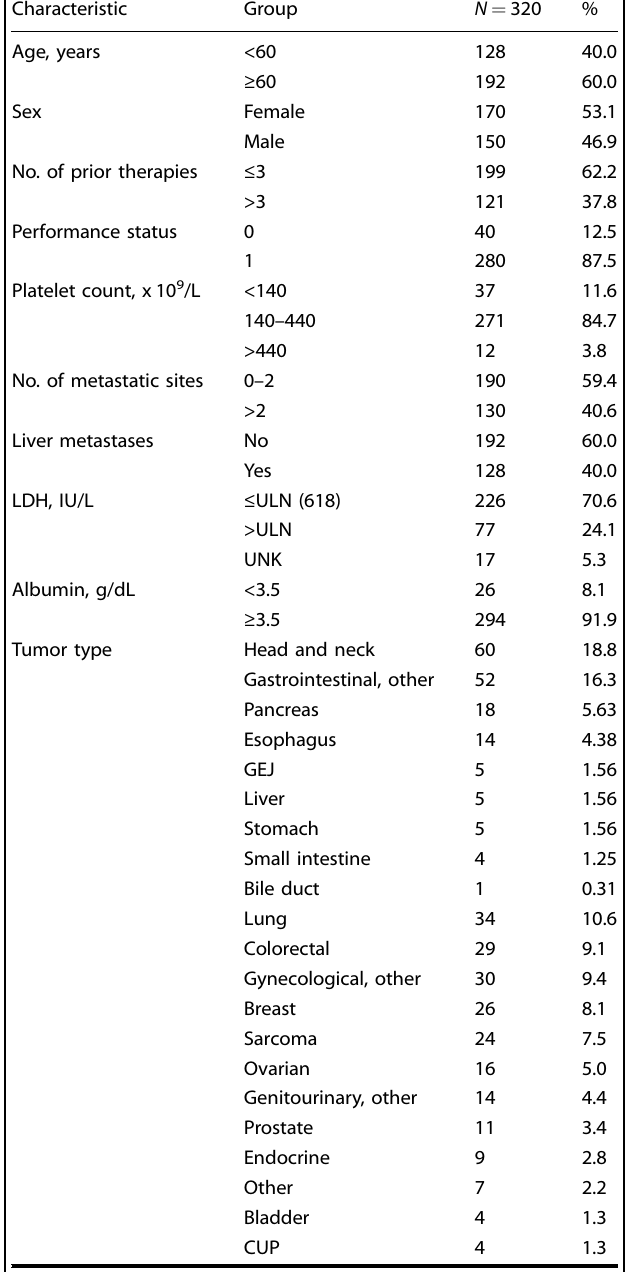
Table 1. Baseline